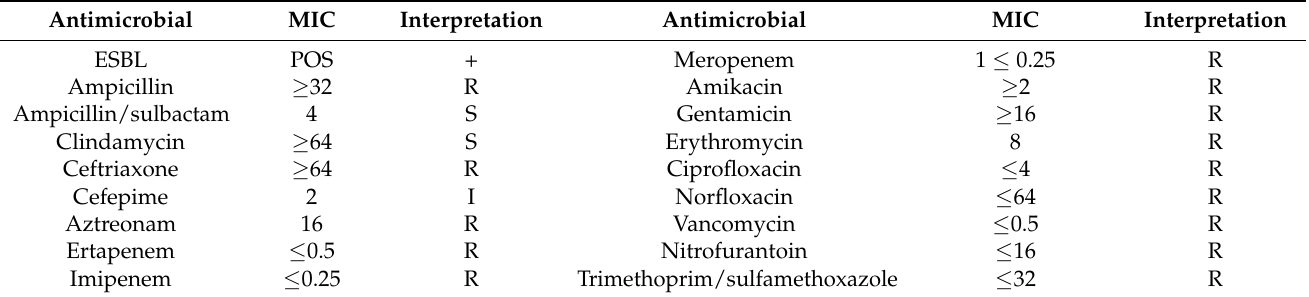
Table 2. VITEK 2 system for the identification and susceptibility testing of Enterococcus faecalis . Antimicrobial MIC Interpretation Antimicrobial MIC